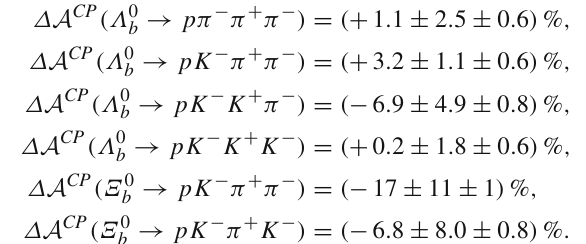
Fig. 2 Invariant p π − π + π − mass distributions with the results of the fit superimposed: (first row) full phase space, (second row) LBM → (Λ + → p π − π + )π − control channel. The and (third row) Λ 0 c b two columns correspond to the charge-conjugate final states: (left) baryon, (right) antibaryon. The different components employed in the